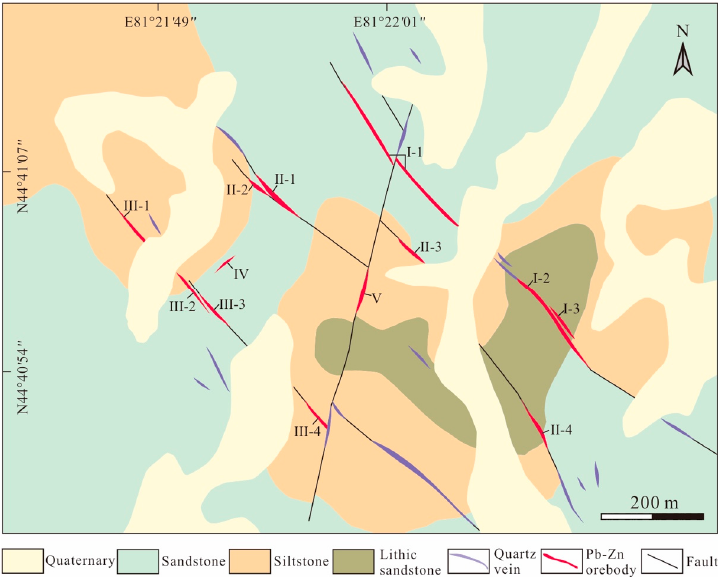
Figure 2. Geological map of the Kuergasheng Pb–Zn deposit (modified after Liu et al. [15]).